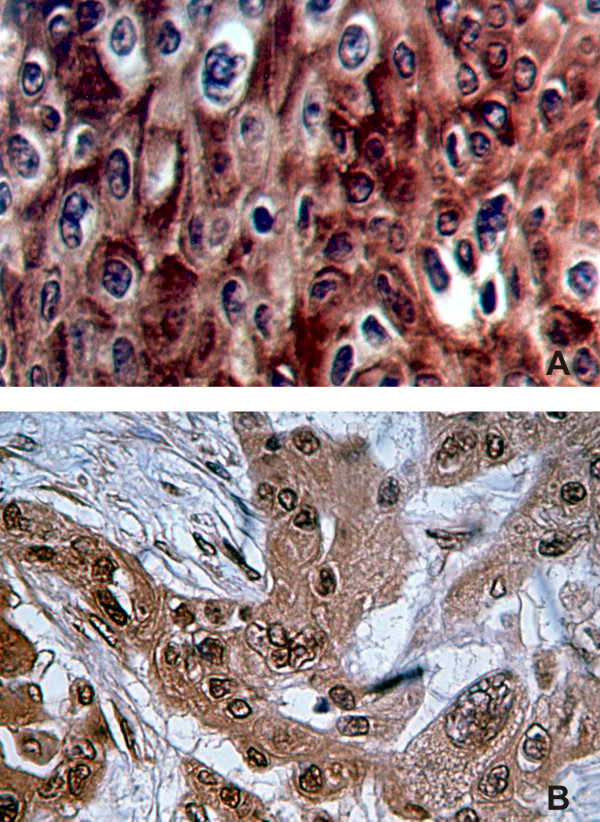
a – Immunohistochemical detection of MUC1 extracellular epitopes. A stage III larynx carcinoma specimen incubated with anti-MUC1 C595 monoclonal antibody is shown. Cell membrane and cytoplasm are stained over all the picture with a microvesicular pattern. Staining is strong inalmost all cells as well as in high proportion of intercellular connections. b – Immunohistochemical detection of MUC1 cytoplasmic tail epitopes. Section of a stage IV larynx carcinoma incubated with CT33 antibody is shown. Different cellular patterns are identified. Intense reaction is observed along the cytoplasm with a granular pattern and linear at nuclear membrane. Plasma membrane is partially stained. Cells are polymorphic as well as nuclei, showing different size and vesicular nuclear patterns. Some intercellular bridges are also stained with this antibody.